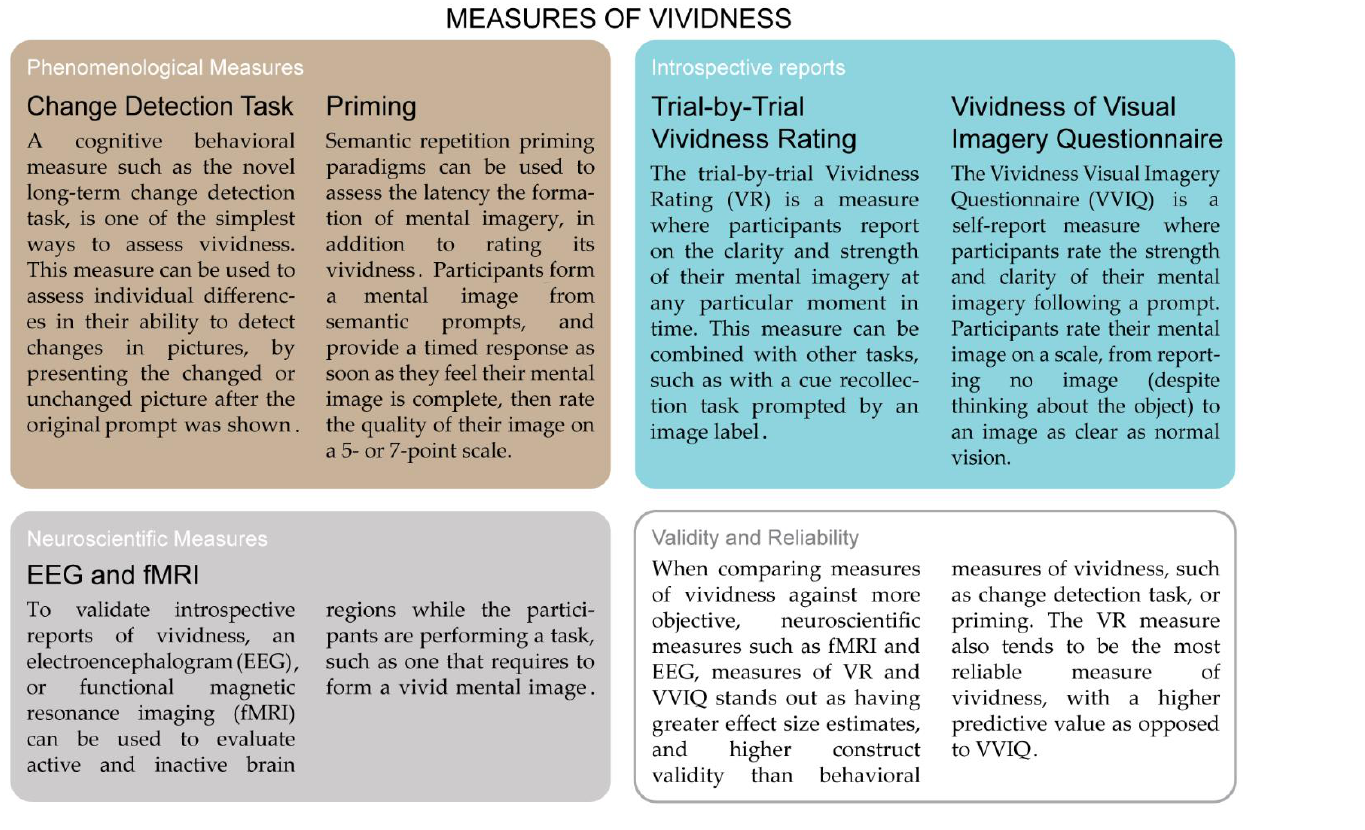
Figure 5. An overview of past and current measures of vividness in cognitive sciences. These measures are generally used to assess individual differences in mental imagery vividness. Phe- nomenological Measures: change detection task [65], priming [17]; Introspective Reports: trial-by trial vividness rating: [66], vividness of visual imagery questionnaire [55]; Neuroscientific Measures [67,68]; Validity and Reliability